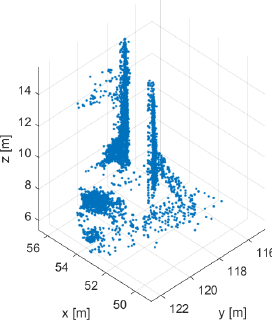
Figure 9. Example of classification error: object classified in the cantilever mast class instead of “other”.